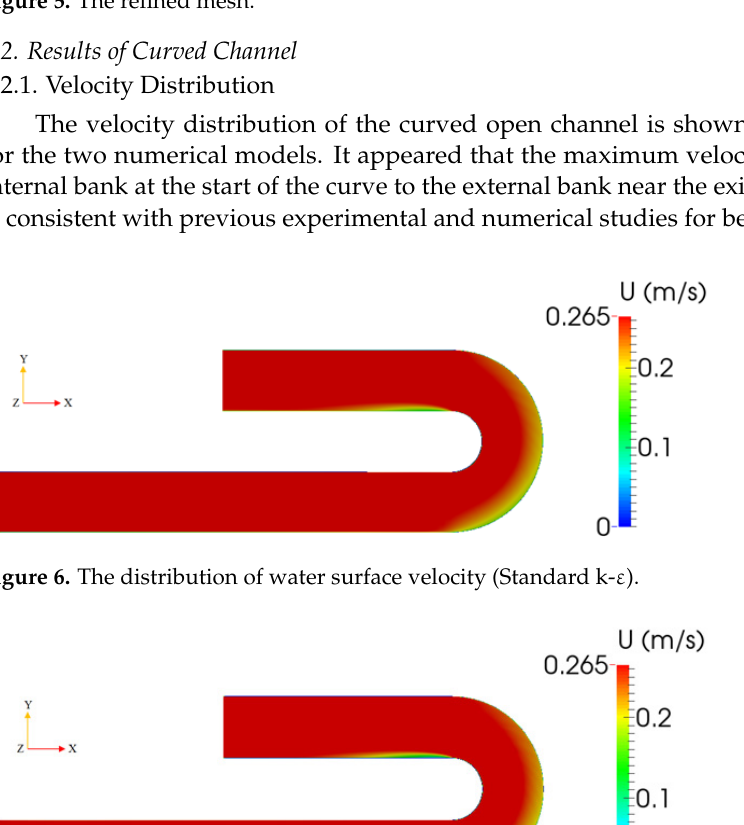
Figure 5. The refined mesh .